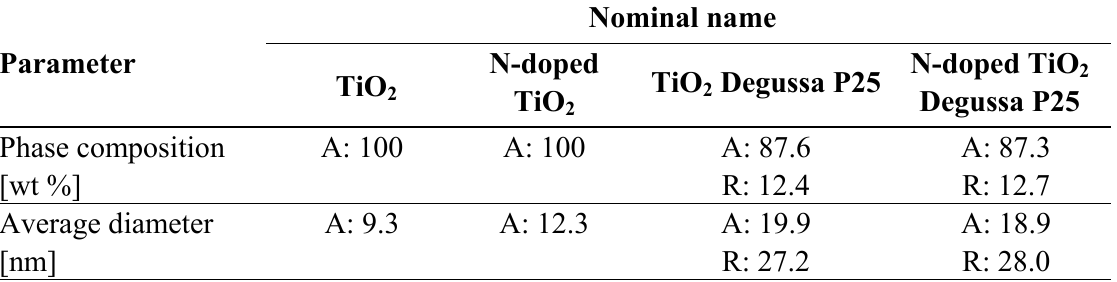
Table 1. Phase composition and average diameter of the crystallites in the studied samples.